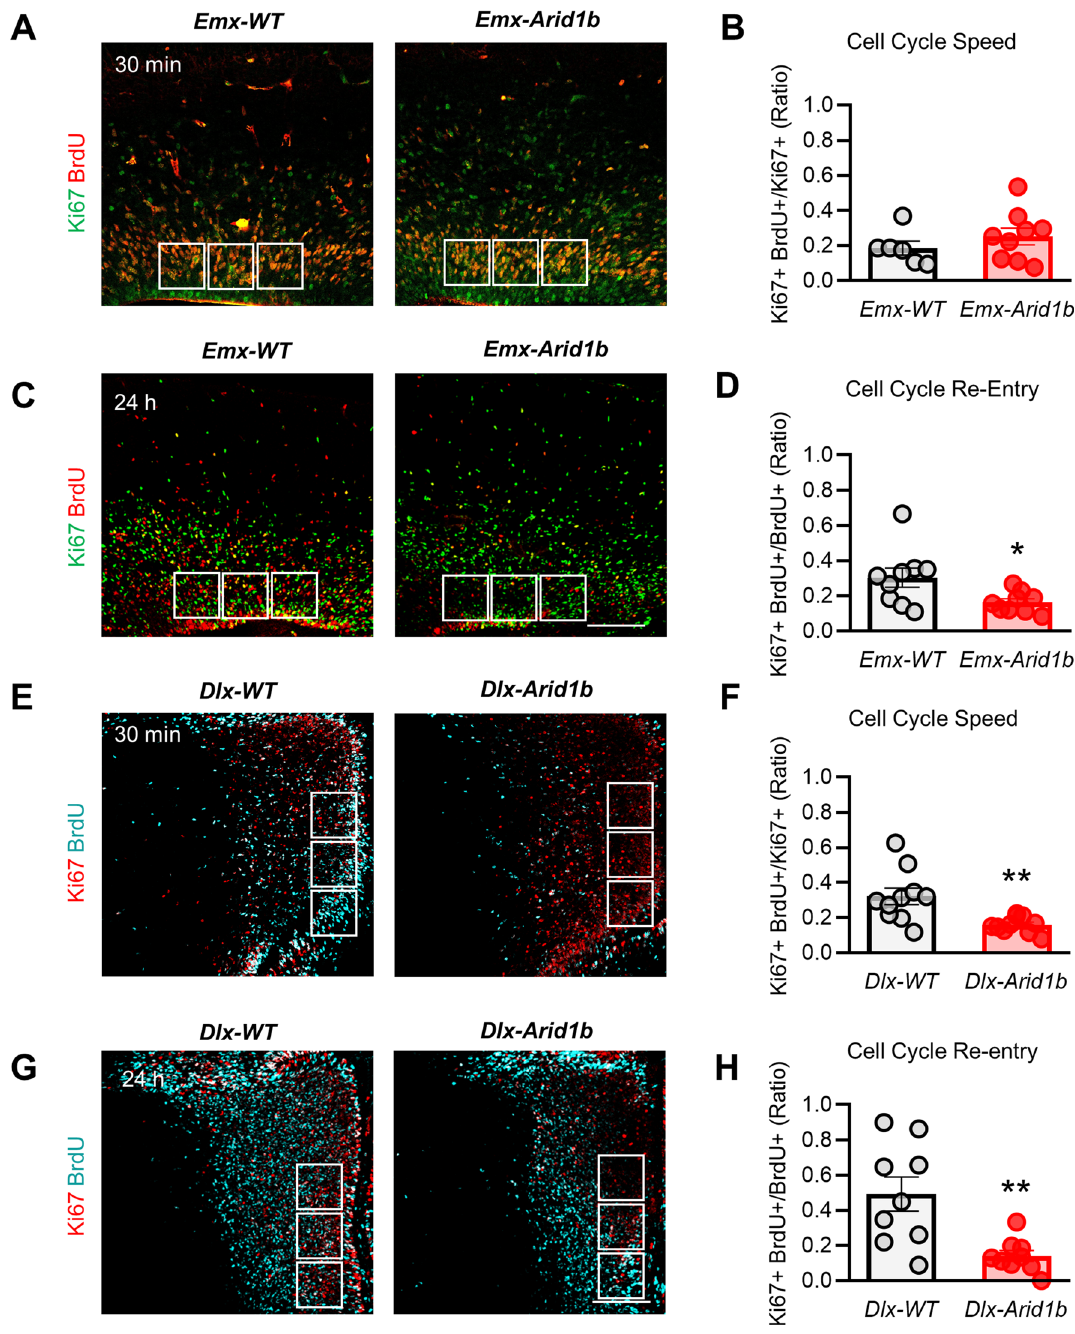
Figure 3. ARID1B regulates the cell cycle in neural progenitors. ( A ) and ( E ) E14–16 control and Emx-Arid1b or Dlx-Arid1b mice were pulse-labeled with BrdU for 30 min, and then brain regions containing the cerebral cortex were collected and immunostained using BrdU and Ki67 antibodies. Scale bar: 50 μm. White boxes (2.5 mm 2 ) indicate regions of interest in the VZ of the developing cerebral cortex (for Emx-Arid1b mice) or MGE (for Dlx-Arid1b mice) that were quantified and averaged for each animal. ( B ) and ( F ) Quantification of cell cycle speed from ( A ) and ( E ). The cell cycle speed was defined as the fraction of BrdU- and Ki67-double-positive cells in the total Ki67-positive pool in the cerebral cortex. N = 6 control and 9 Emx-Arid1b mice for ( B ) and N = 10 for each genotype for ( F ). Statistical significance was determined by two-tailed Student’s t test. Error bars show SEM. ** p < 0.01. ( C ) and ( G ) E14-16 control and Emx-Arid1b or Dlx-Arid1b mice were pulse-labeled with BrdU for 24 h and then brains were collected for immunostaining with BrdU and Ki67 antibodies. Scale bar: 50 μm. ( D ) and ( H ) The index of cell cycle re-entry was calculated as the fraction of BrdU- and Ki67-double-positive cells in total BrdU-positive pool. N = 9 mice for each genotype from both ( D ) and ( H ). Statistical significance was determined by two-tailed Student’s t test. Error bars show SEM. * p < 0.05, ** p <